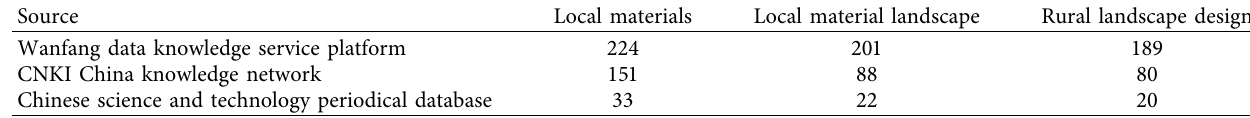
Table 3: Research trends in the fields of local materials, local material landscapes, and rural landscape design.